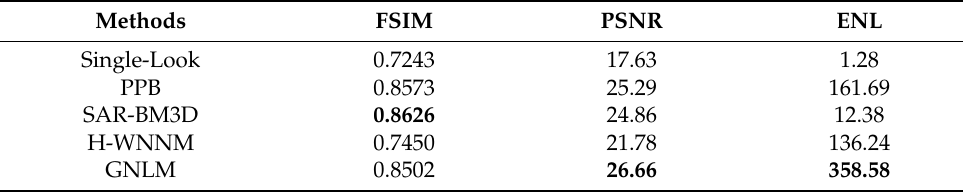
Table 1. FSIM, PSNR, and ENL of the selected despeckling